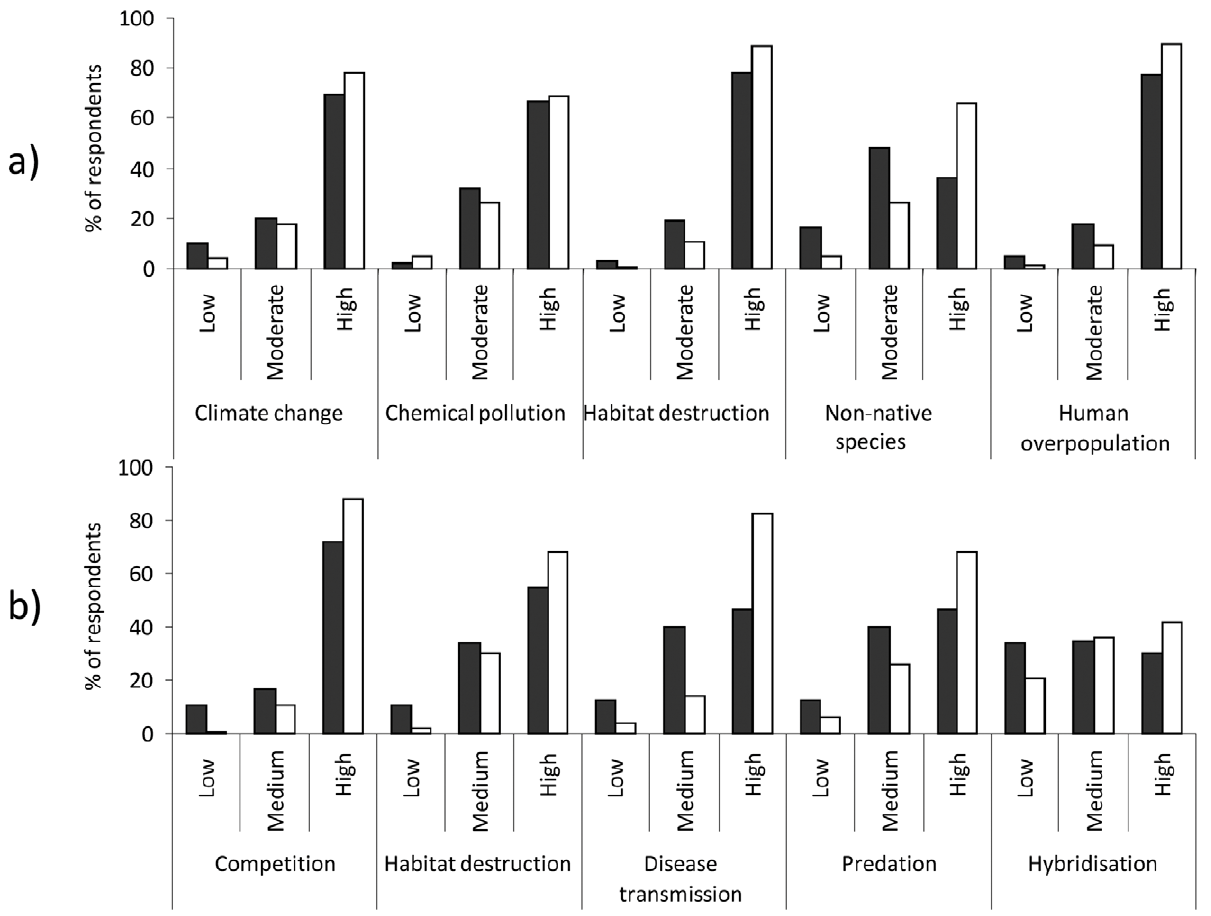
Figure 1. Public and conservaton managers’ threat perception concerning conservation issues. Public (black; n=186) and conservation manager (white; n=132) threat perception (%) for a) anthropogenic driven conservation issues and b) non-native species introductions.